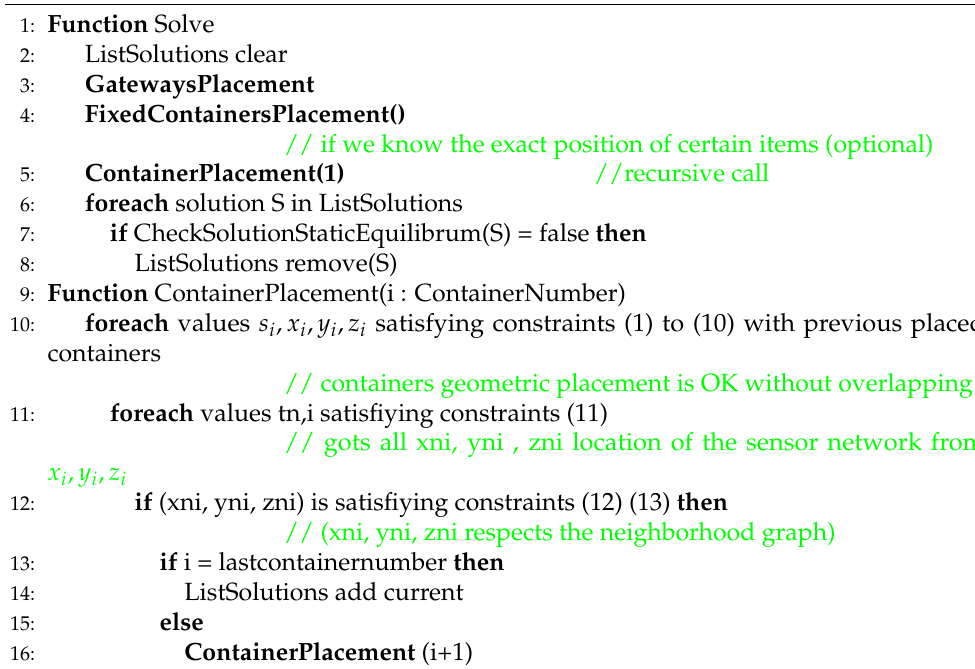
Algorithm 1 Developed